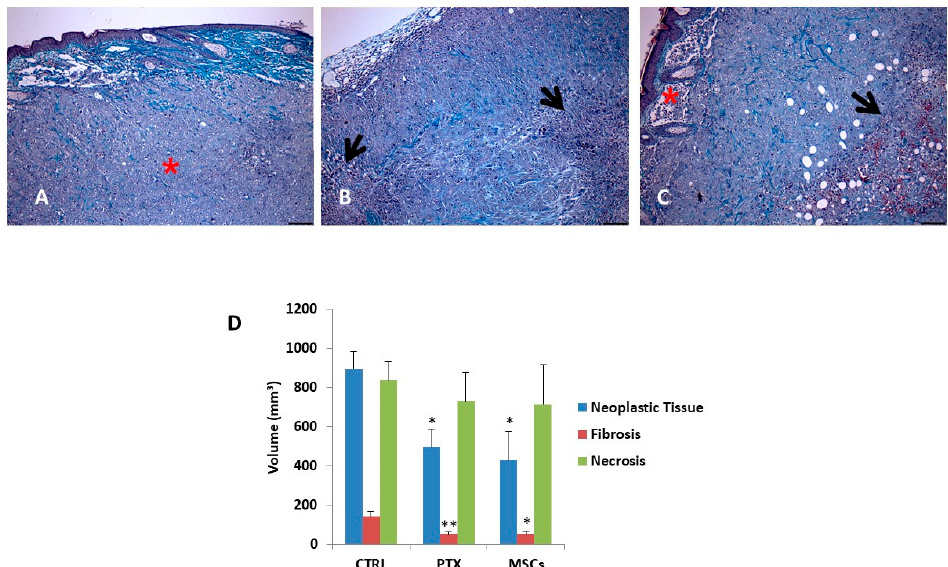
Figure 6. Morphometric analysis of tumor xenografts. Selected sections from MSTO-211H xenografts untreated (CTRL, A ), treated with paclitaxel (PTX) ( B ) or with MSCs ( C ) stained by Masson’s Trichrome to distinguish the fibrotic tissue (greenish) from neoplastic cells (purple). Black arrows in B and C point to necrotic areas, some of which show pigmented (reddish) debris. Red asterisks in A and C indicate skin and adnexa. Scale bars = 100 µ m. ( D ) Bar graph showing the quantitative evaluation of tissue composition (neoplastic tissue, fibrosis and necrosis) in tumor xenografts. Data are expressed as means ± SEM. * p < 0.05, ** p < 0.02 vs. control group.